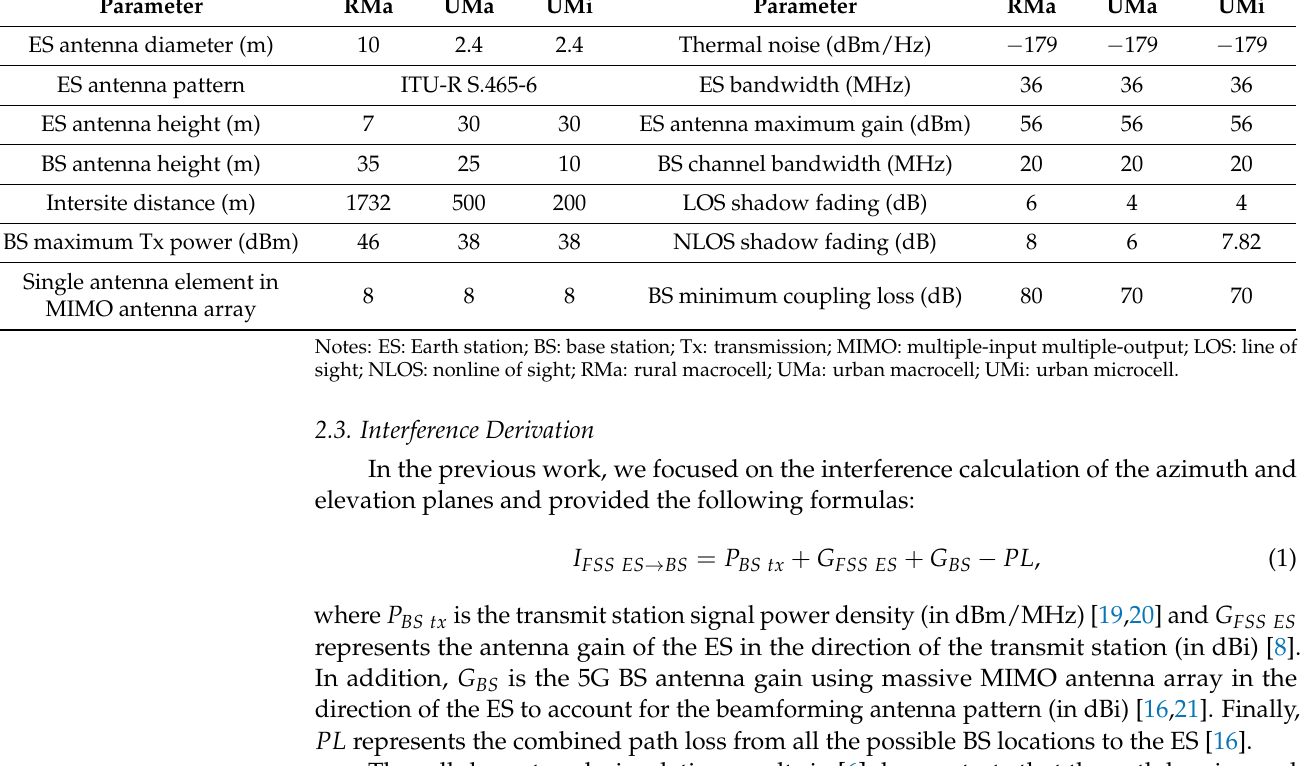
Table 2. Fixed-satellite service (FSS) Earth station parameters [15–18].